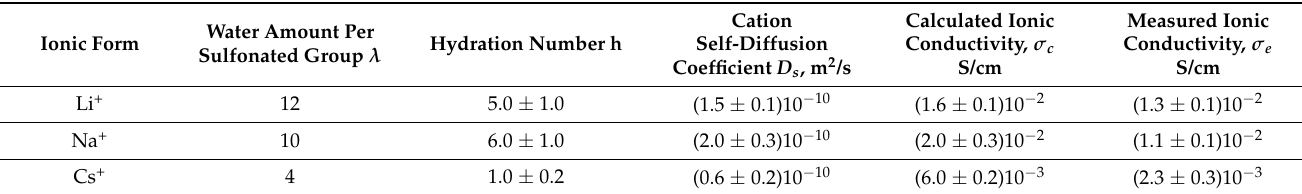
Table 9. Water content λ , hydration number h , self-diffusion coefficients D s , calculated conductivity σ c , measured conduc- tivity σ e of Li + , Na + , Cs + cations in Li + , Na + , Cs + Nafion 117 membrane ionic forms, RH = 98%, t = 20 ◦ C [109]. Cation Water Amount Per Ionic Form Hydration Number h Self-Diffusion Sulfonated Group λ